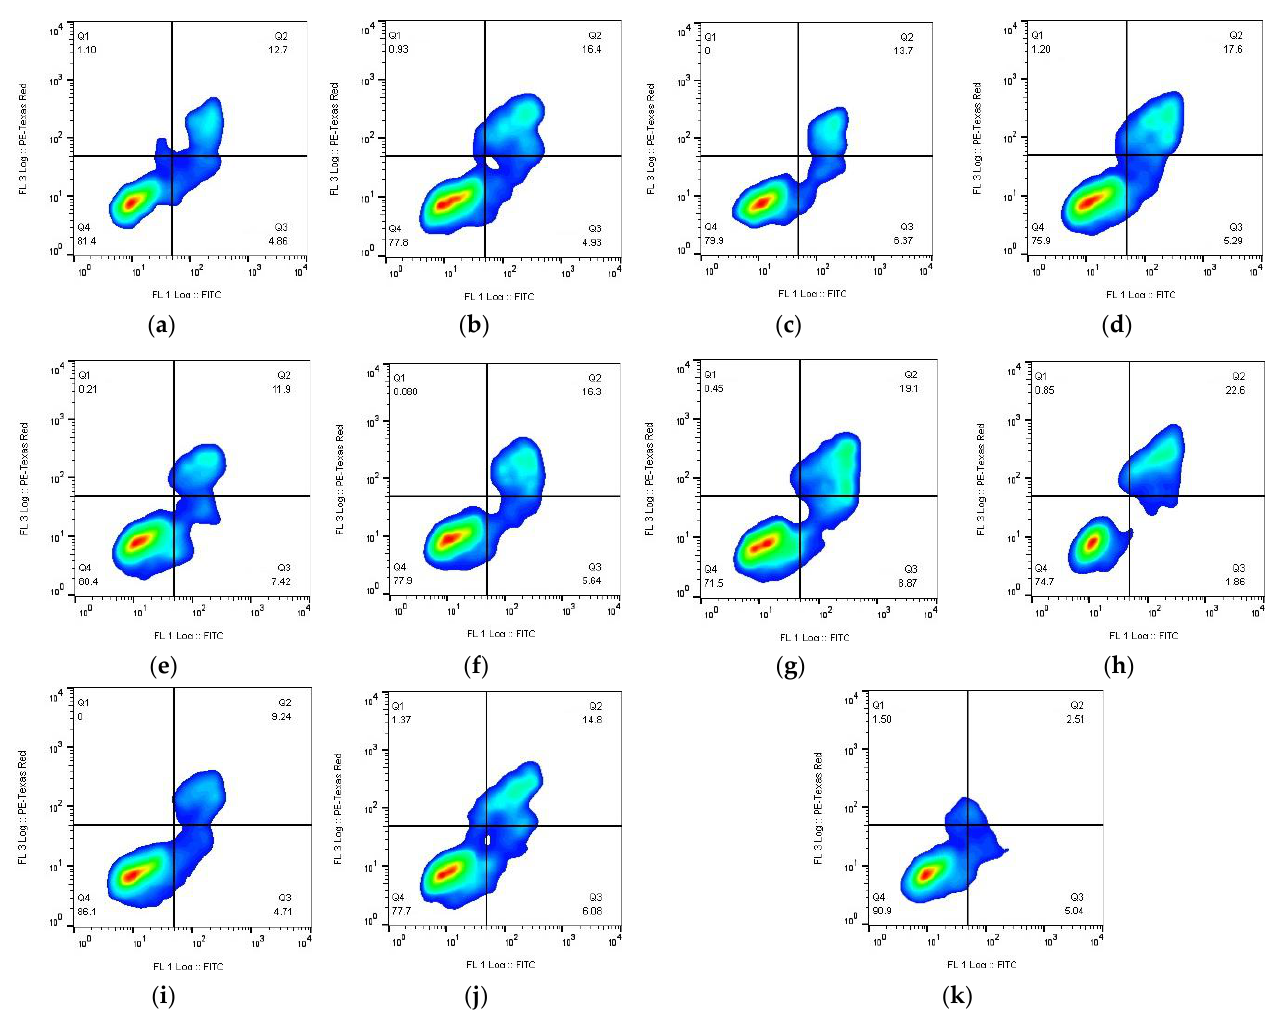
Figure 11. The plots represent apoptotic and necrotic A549 cell populations after 1 h of incubation with the NPs loaded with the derivatives synthesized and the drug substances: ( a ) Kpt and ( b ) Kpt-NP; ( c ) Kpt1 and ( d ) Kpt1-NP; ( e ) Kpt2 and ( f ) Kpt2-NP; ( g ) Kpt3 and ( h ) Kpt3-NP; ( i ) Kpt4 and ( j ) Kpt4-NP; Control represents untreated cells ( k ). The populations characterized with annexin V-FITC fluorescence are early apoptotic and observed at right lower quadrants; the populations characterized with double PI and annexin V-FITC fluorescence are late apoptotic/necrotic and observed at upper right quadrants.